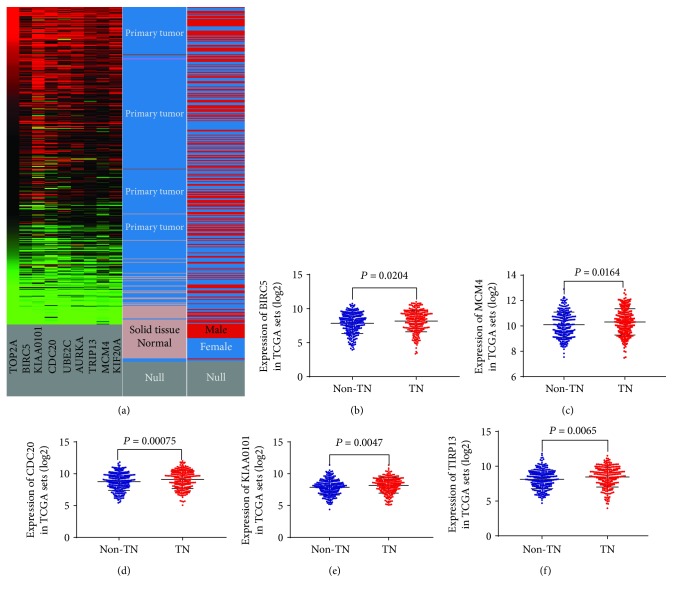
mRNA expression of hub genes. (a) The mRNA expression of 9 hub genes (TOP2A, BIRC5, KIAA0101, CDC20, UBE2C, AURKA, TRIP13, MCM4, and KIF20) between LAD and normal tissues based on the UCSC Xena database. 5 hub genes, namely, BIRC5 (b), MCM4 (c), CDC20 (d), KIAA0101 (e), and TIRP13 (f), were more significantly upregulated in triple-negative (TN) lung adenocarcinomas based on TCGA database than in non-triple-negative (non-TN) lung adenocarcinomas.